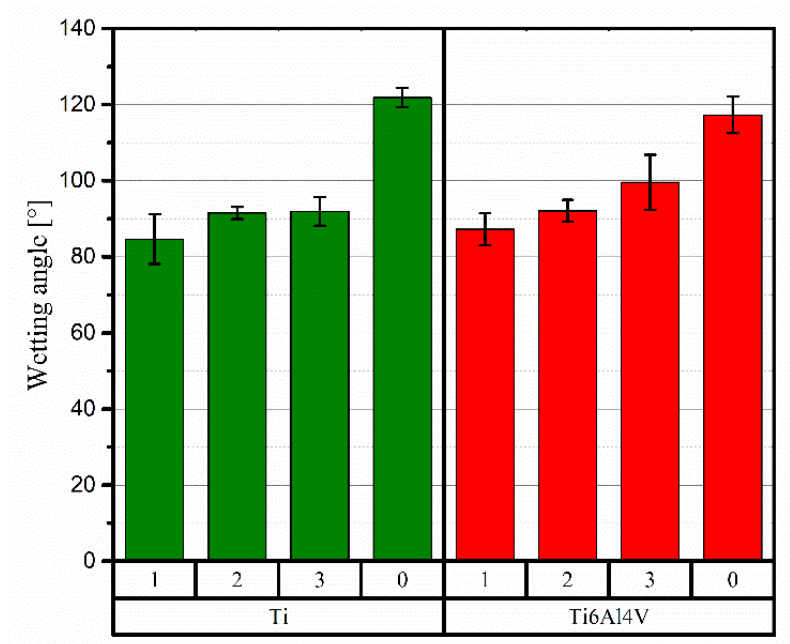
Figure 12. Results of the wetting angle measurements.